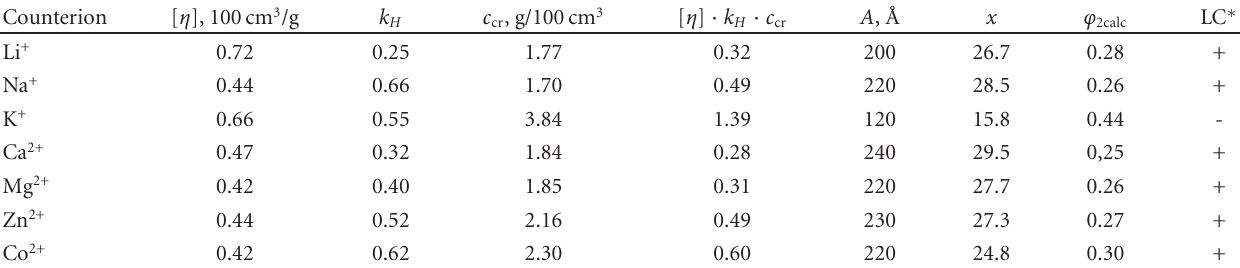
Table 7: Hydrodynamic characteristics of CAS salts aqueous solutions and parameters of polymer chain rigidity. Counterion